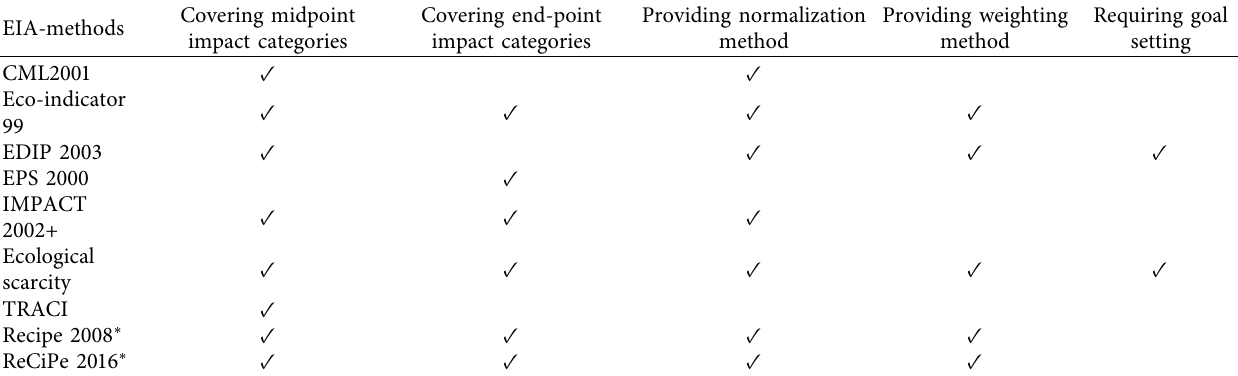
Table 4: Methods of environmental impact assessment